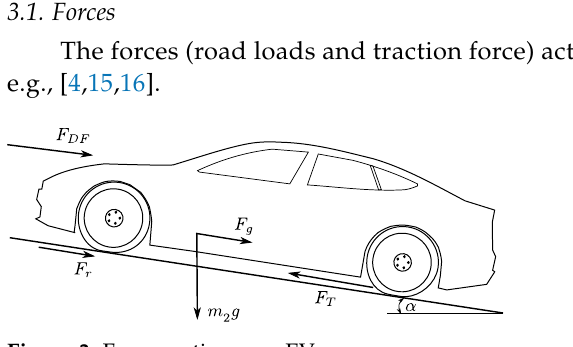
Figure 3. Forces acting on a